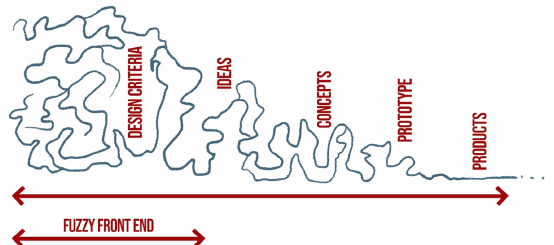
Figure 1. Visual representation based on the fuzzy front-end